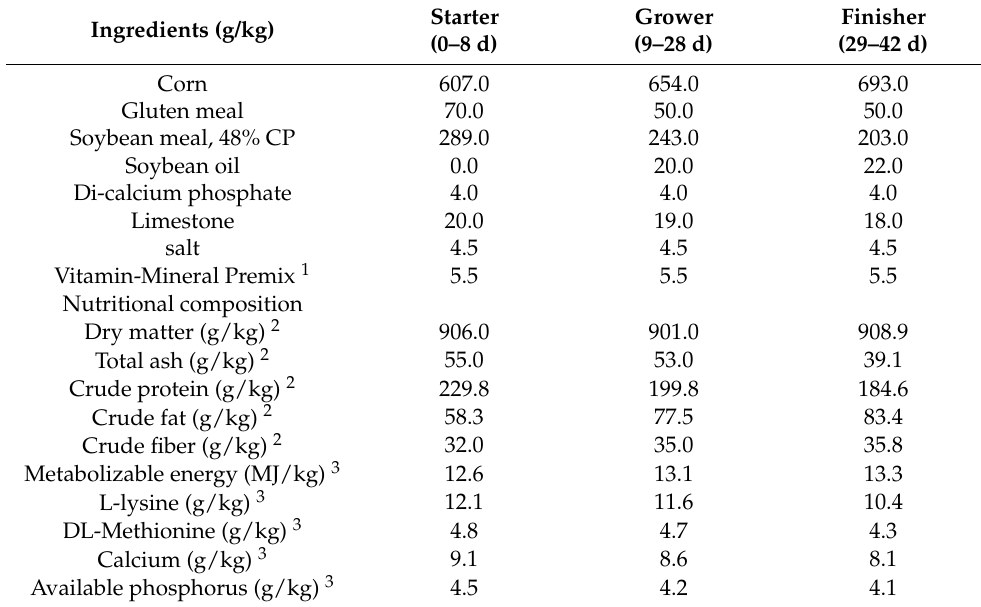
Table 1. Ingredients and nutritional composition of the basal